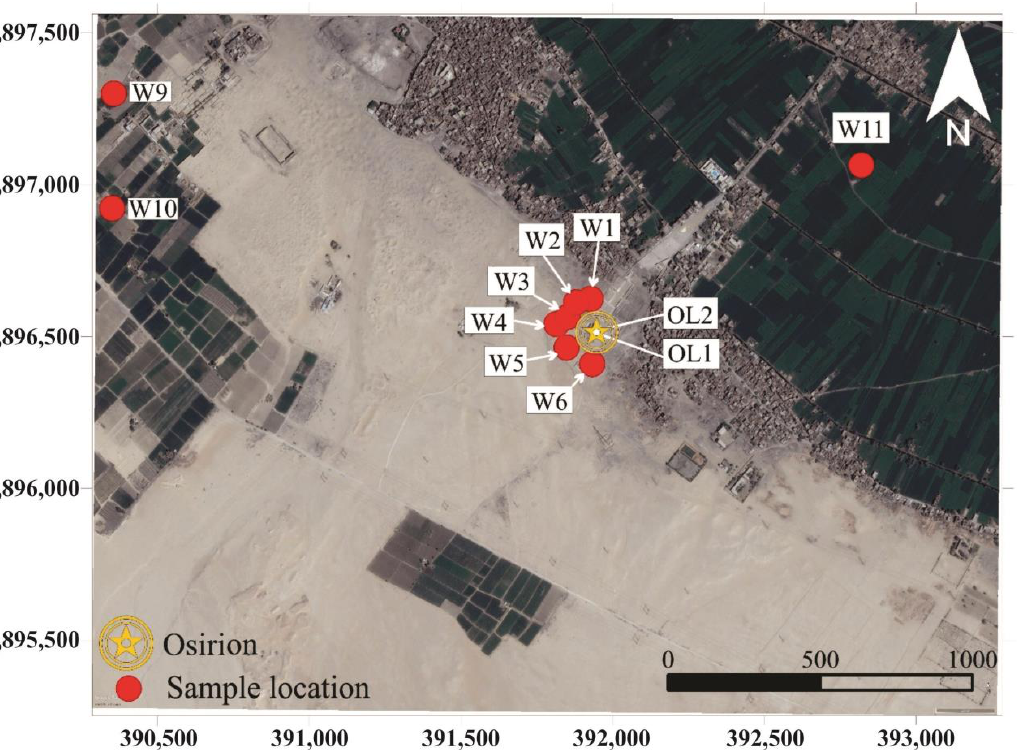
Figure 8. Location map of the Osirion lake samples (OL1 and OL2) and drilled wells around